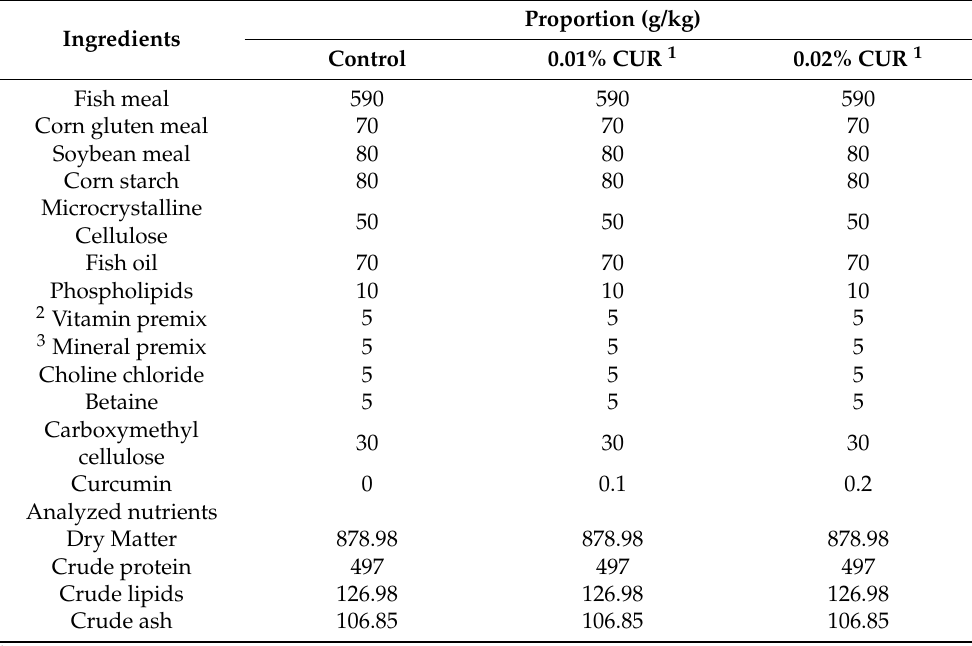
Table 1. Formulation and proximate composition of the experimental